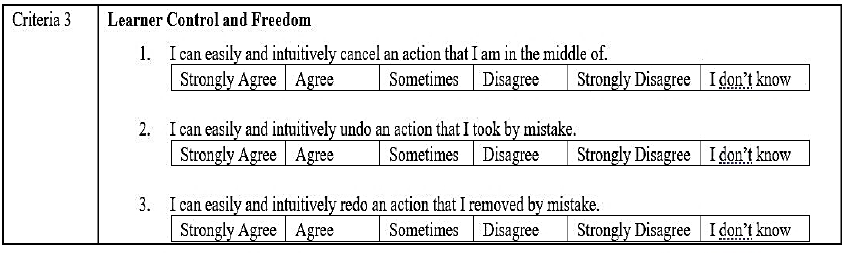
Fig. 3. Interactive usability question sample